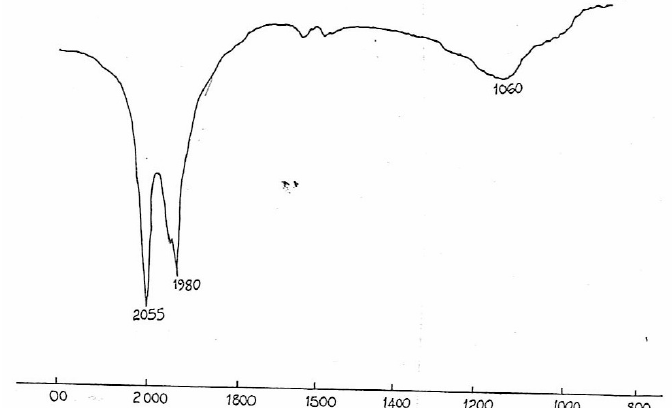
Figure 3. IR specturm of 1,4- η -2-methoxycyclohexa-1-3-diene- N -pyridino iron